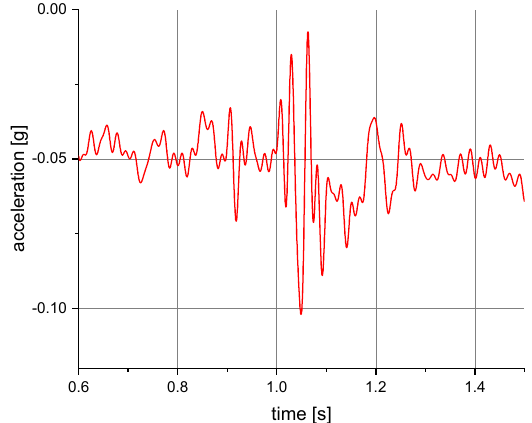
Figure 9. Acceleration as a function of time recorded during tipping. Test conditions: self-locking device at floor level; back point of the safety harness; the sensor mounted on the back of the manikin.